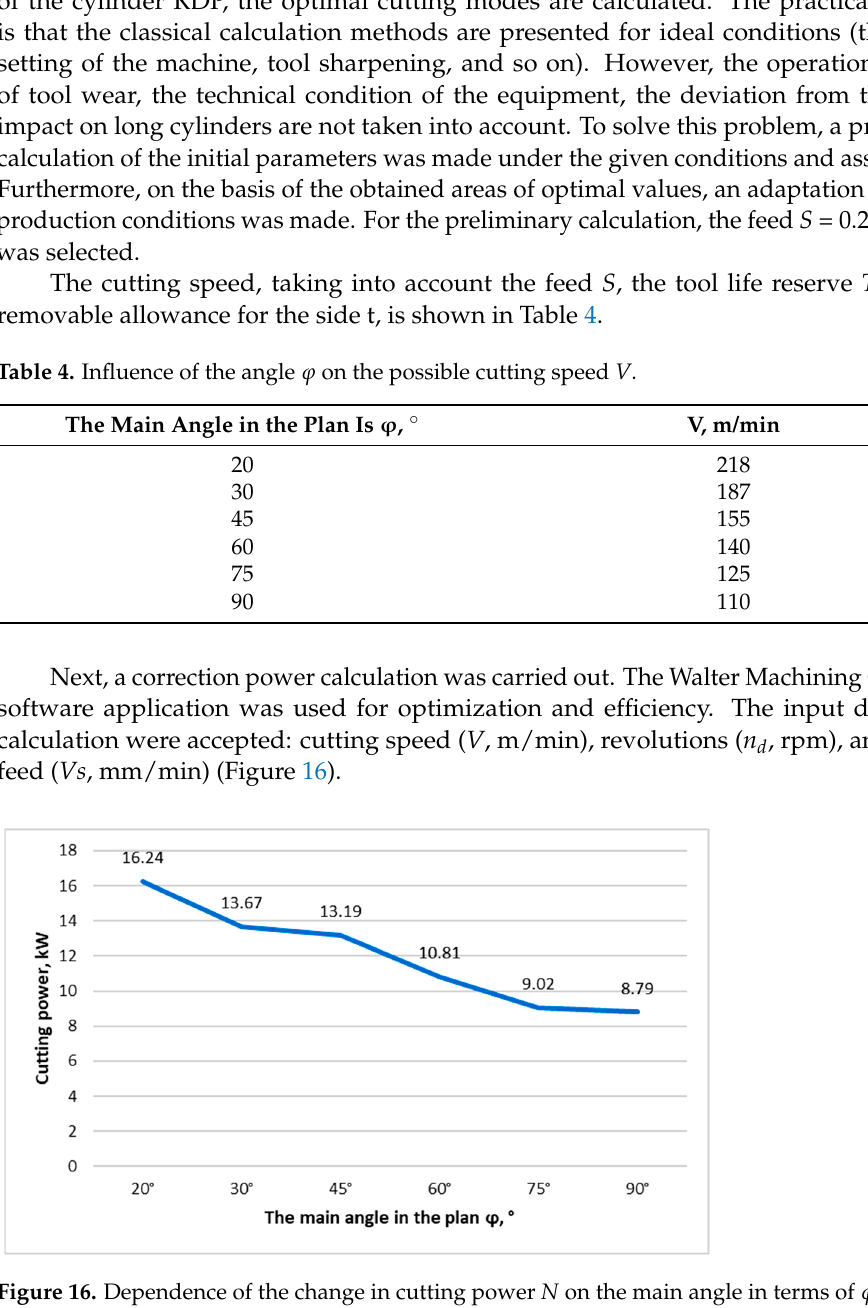
Table 4. Influence of the angle φ on the possible cutting speed V.